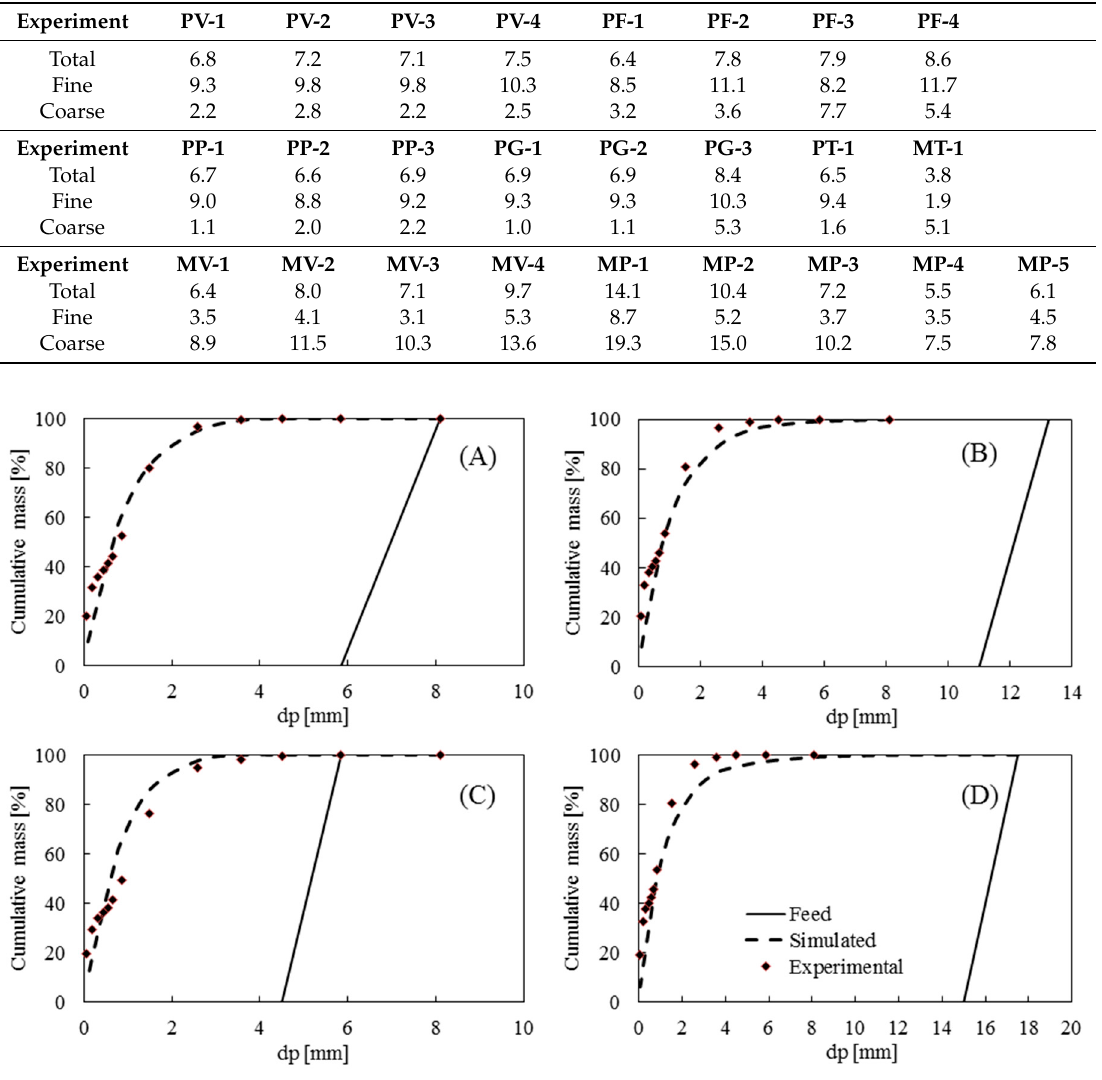
Table 5. Root mean square error (RMSE) results for all experiments. In this work, the fine phase was considered as all particles under 855 microns and coarse phase was over this cut-size.